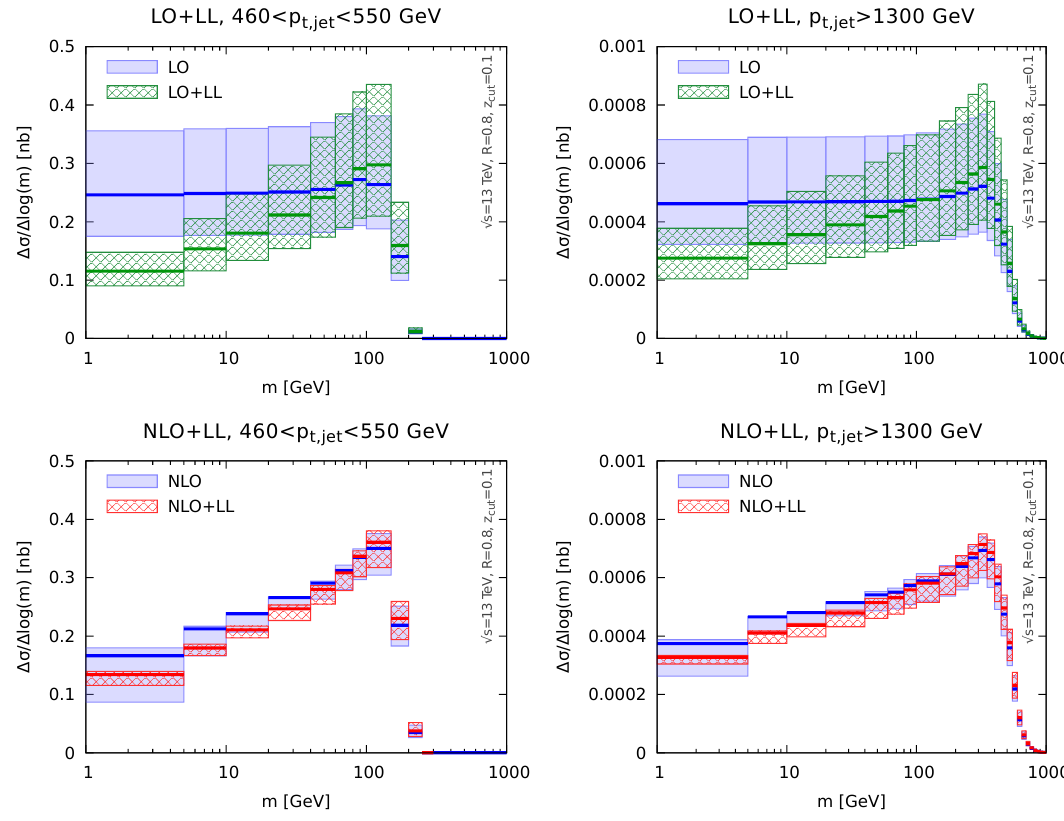
Figure 1 . In this (cid:12)gure we show the resummed and matched jet mass distribution in the 460 < p t; jet < 550 GeV transverse momentum bin (on the left), and in the p t; jet > 1300 GeV bin (on the right). The top panels show LO+LL, while the bottom panels show